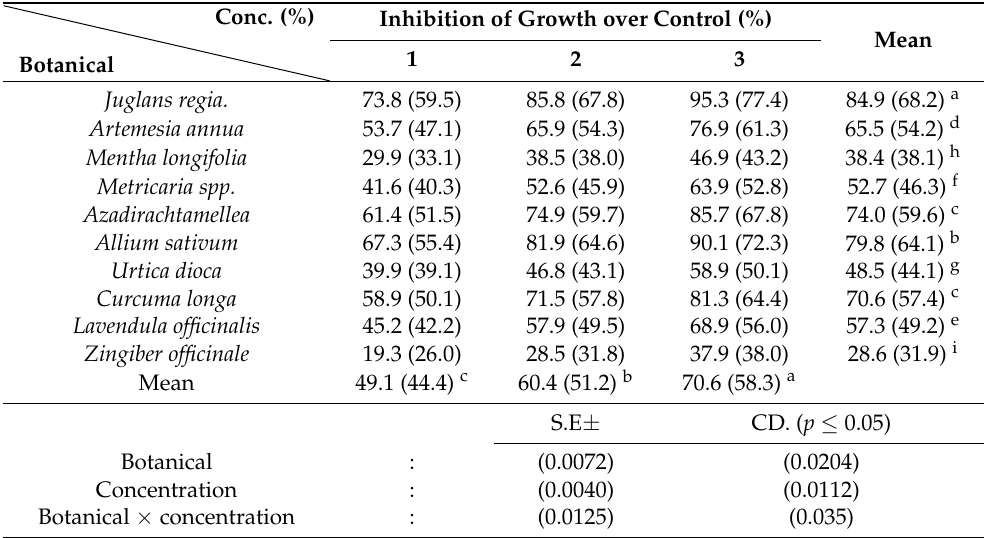
Table 2. In vitro evaluation of botanicals against the green mold pathogen ( Trichoderma harzianum ) at concentrations between 1 and